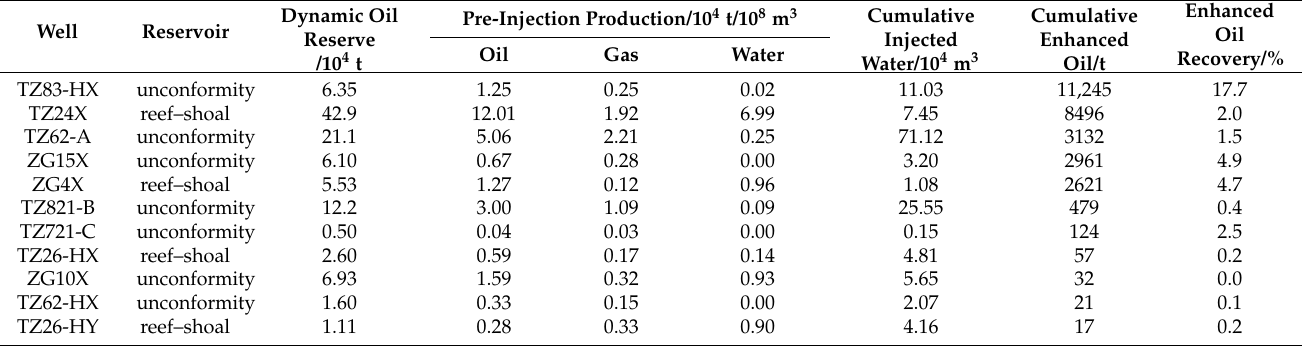
Table 2. Water injection effect in Tazhong I